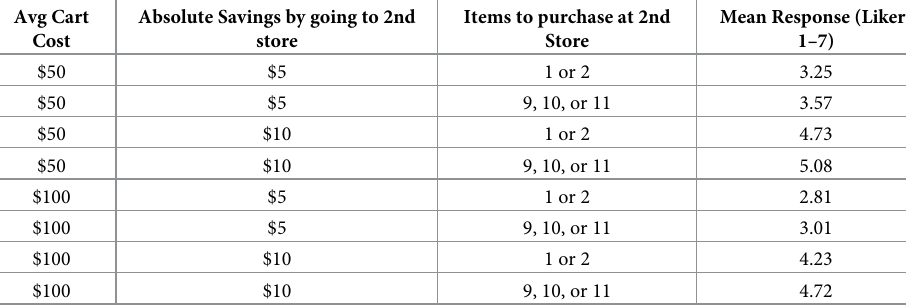
Table 3. Mean cart values (n = 101) (Study 1).